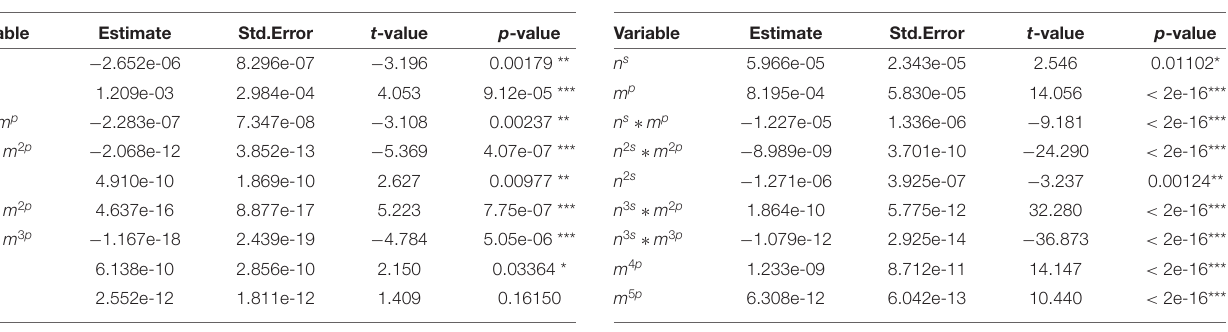
The symbols * , ** , *** designate the statistical significance level of the variables in a given